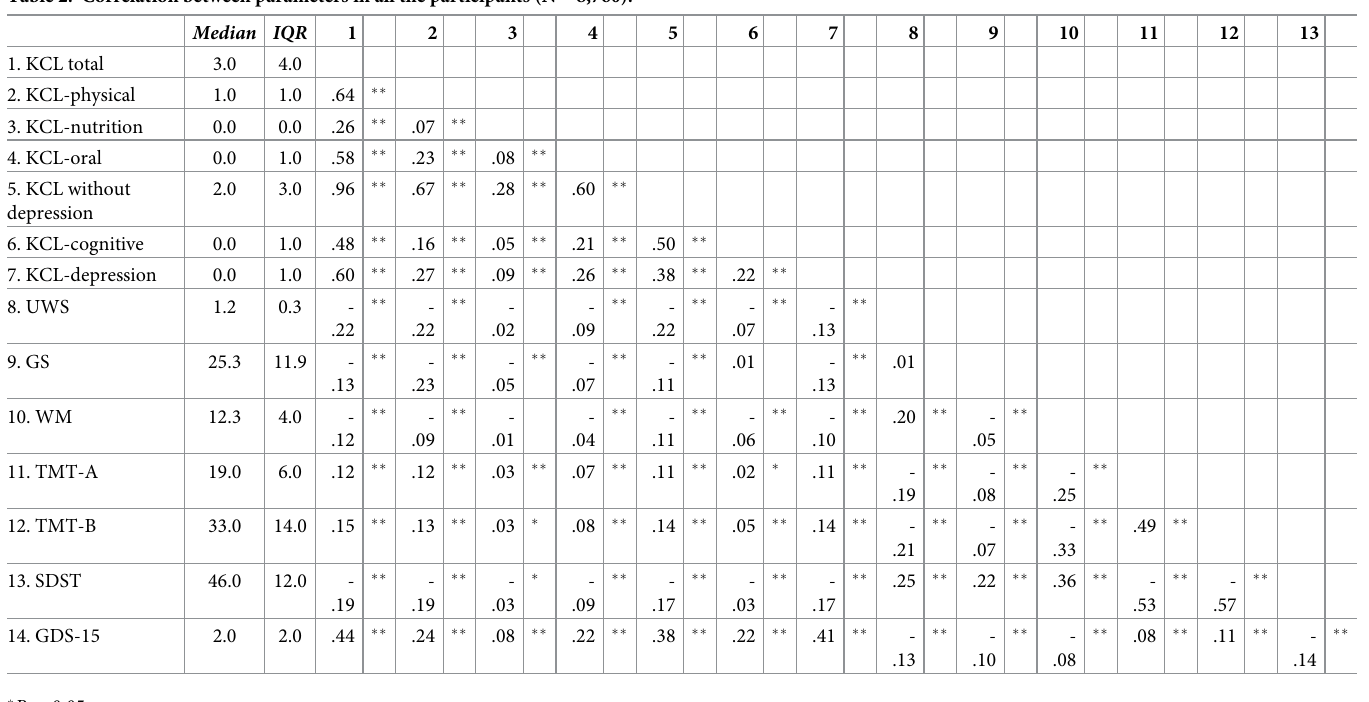
Table 2. Correlation between parameters in all the participants (N = 8,760).